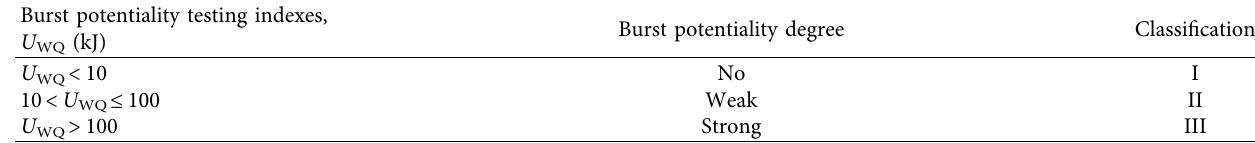
Table 3: Critical index values of burst potentiality about roof and floor.